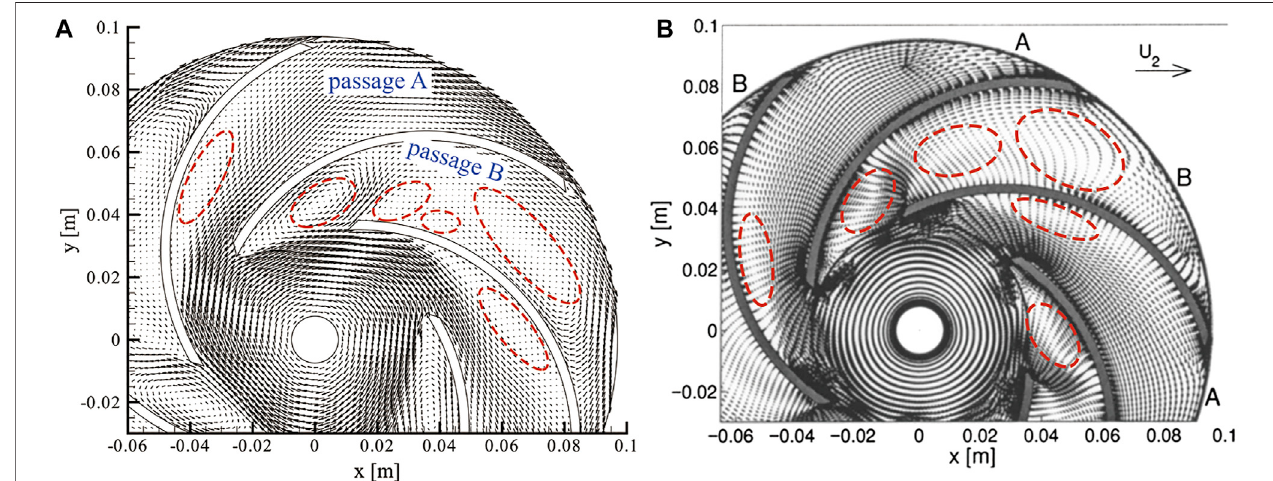
FIGURE 14 | Velocity vector distributions in the impeller mid-height under 0.25 Q 0 fl ow condition: (A) PANS and (B) LES.